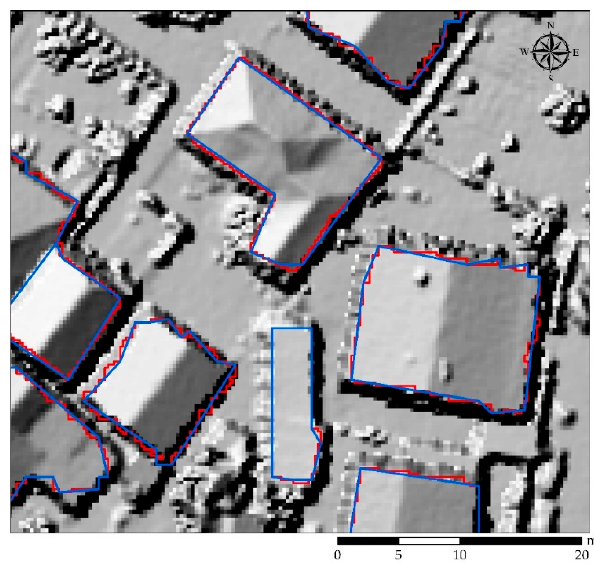
Figure 11. Post-processing results; red line original segments; and blue line simplified segments.